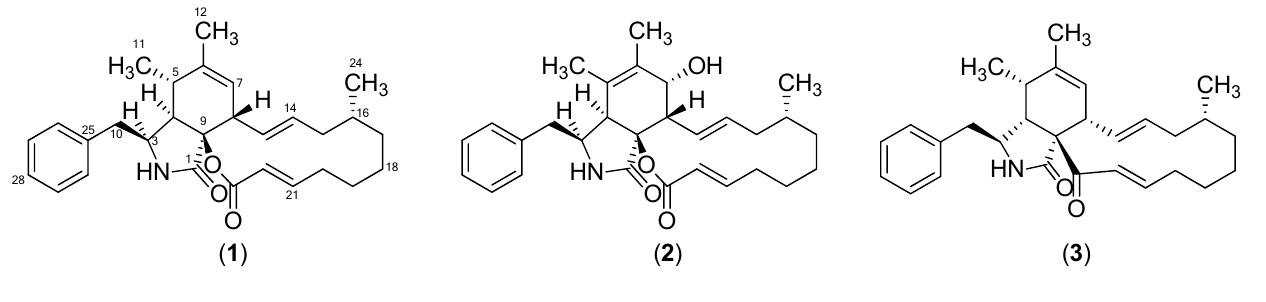
Figure 1. Structures of sclerotionigrin A ( 1 ), sclerotionigrin B ( 2 ) and proxiphomin ( 3